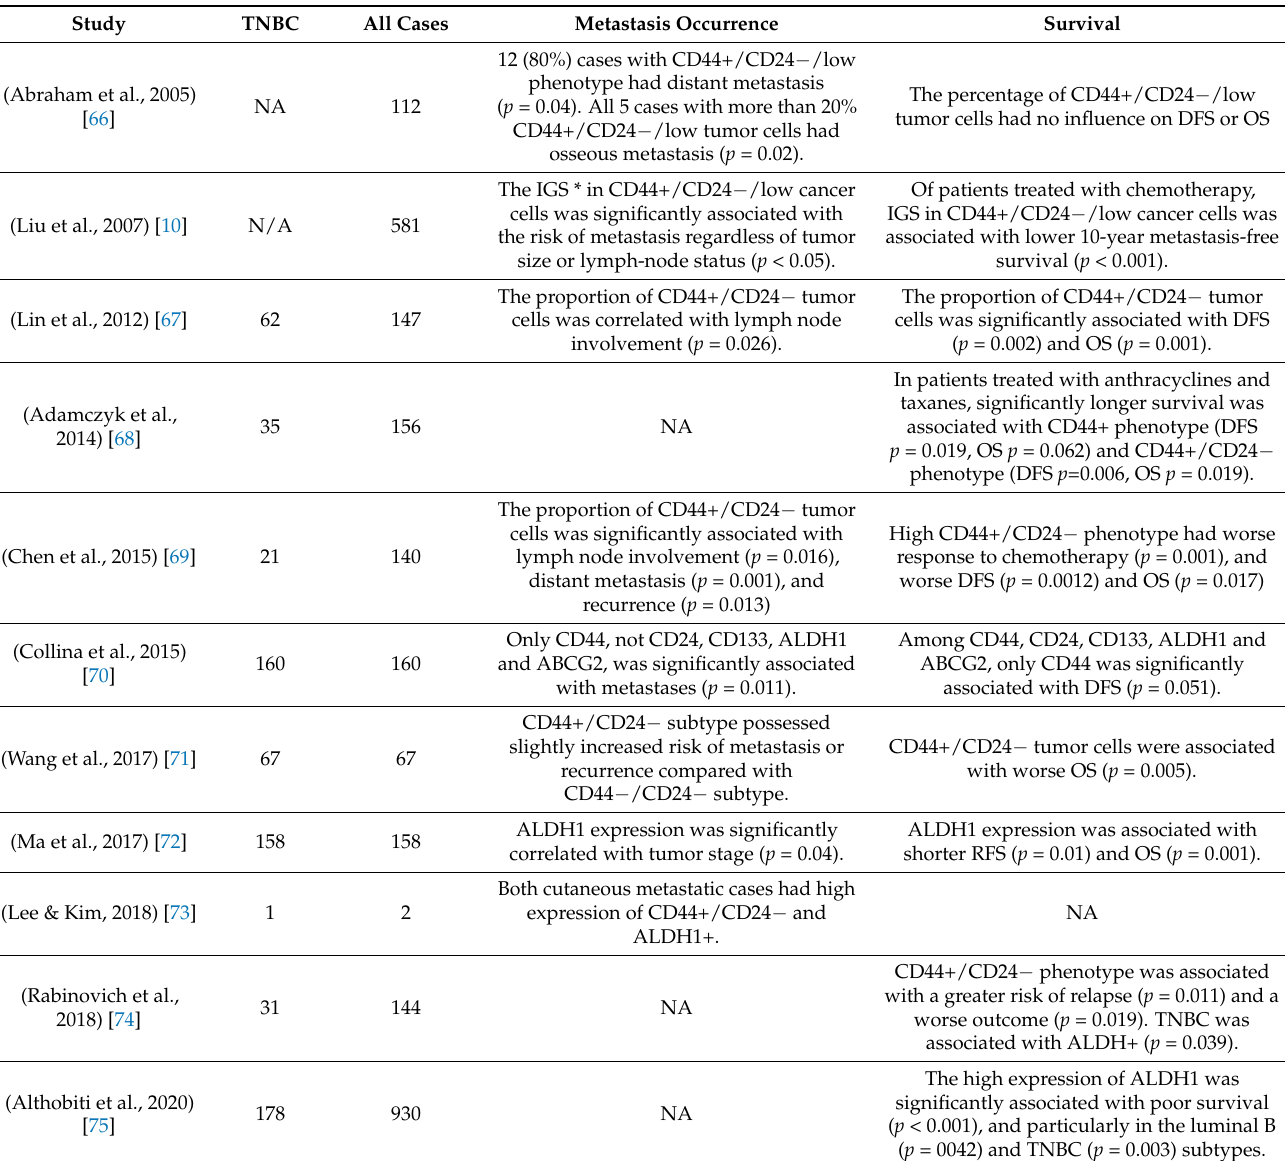
Table 1. Summary of studies on metastasis occurrence and survivals in stem like breast